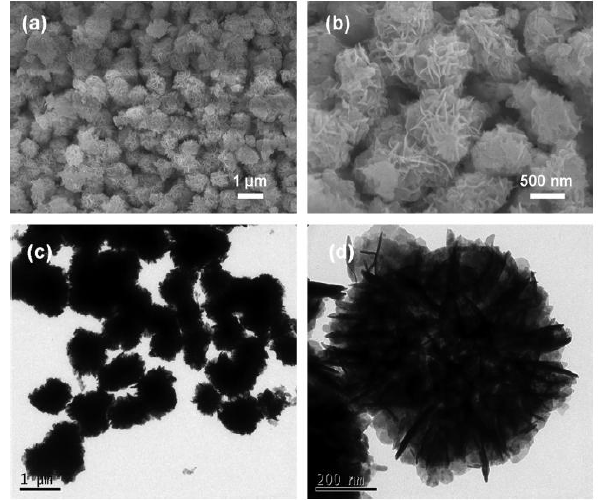
Figure 1. SEM ( a , b ) and TEM ( c , d ) images of BiOI flower-like spheres (dimensions in the 500 nm − 1 µm range) made up by nanosheets as building blocks. Reprinted from Chem. Eng. J. , 235 Ai, L.; Zeng, Y.; Jiang, J., Hierarchical Porous BiOI Architectures: facile Microwave Nonaqueous Synthesis, Characterization, and Application in the Removal of Congo Red from Aqueous Solution, 331–339. Copyright (2014) with permission from